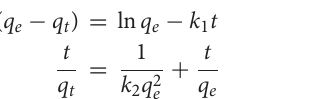
Figure 6B . The adsorption rate and adsorption capacities of PPTA-AM-70 were maximum, due to porous structure and to proceed the bicontinuum process, which occurred either in series or in parallel, being the more common bicontinuum conceptualization (Brusseau et al., 1989). The pseudo-first-order and pseudo-second order models are, respectively, expressed by Equations (2) and